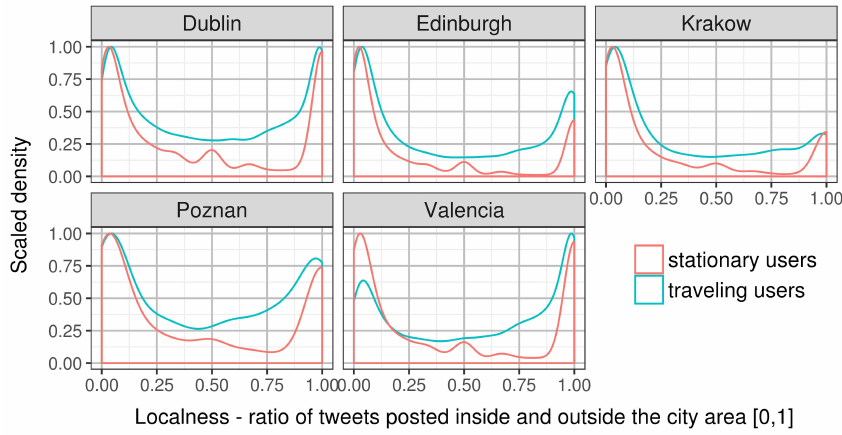
Figure 6. Comparison between mobility classes and localness in selected